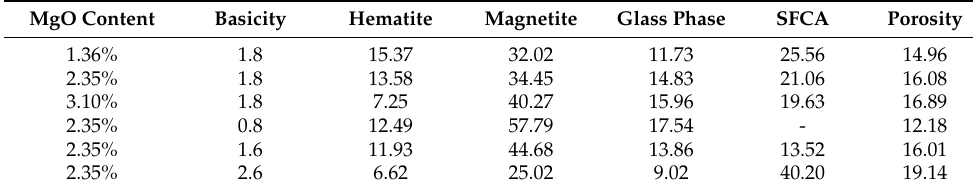
Table 3. Mineral composition of sinter with different MgO content and basicity/area,